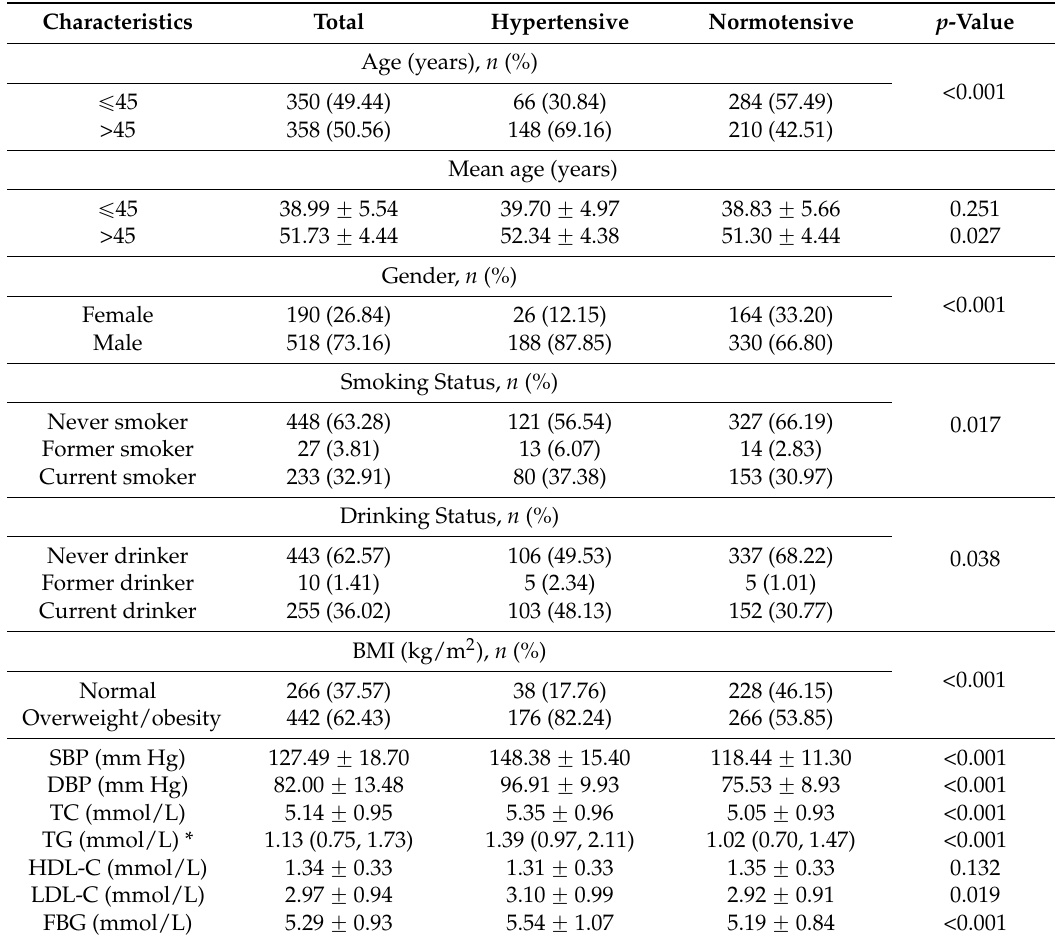
Table 1. The characteristics of the study